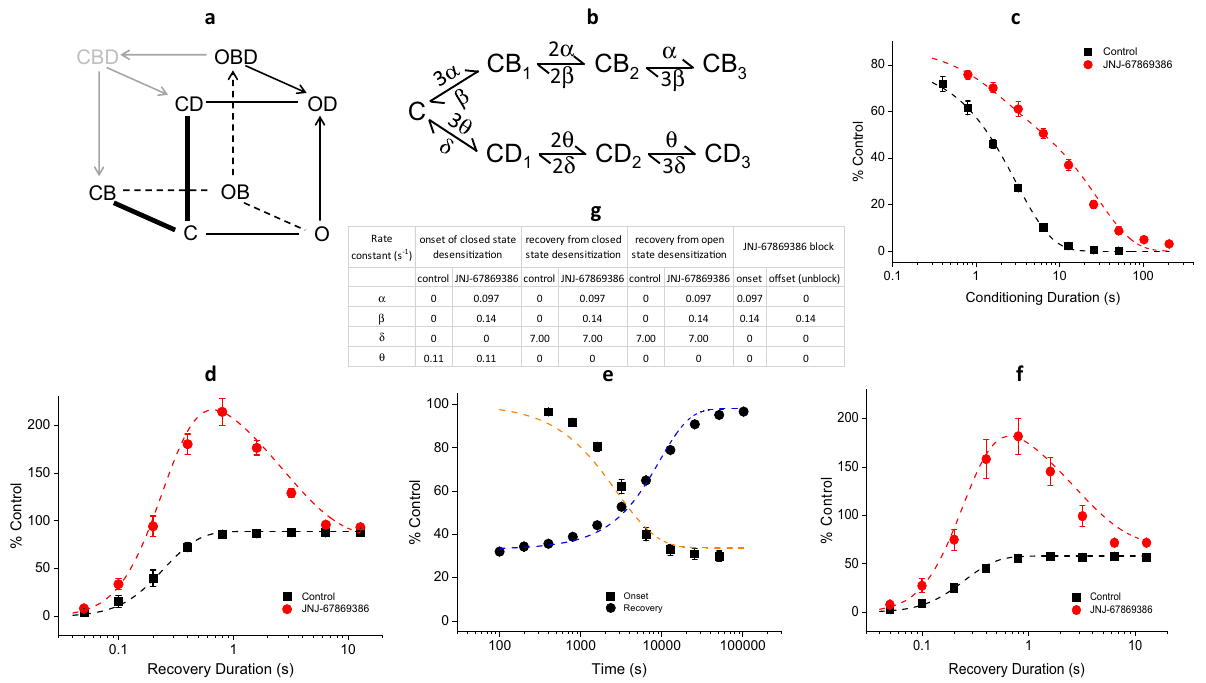
Fig. 6 Kinetic modeling of the effect of JNJ-67869386 on desensitization kinetics. a Qualitative model for channel activation and desensitization in the absence and presence of compound. In the presence of compound, closed-state desensitization and recovery involve only three states, CB, C, and CD (transitions between these states are represented by thick lines). Recovery from (equilibrated) open-state desensitization funnels through the same three states, after an initial rapid transition from OD → CD. Recovery from (unequilibrated) open-state desensitization, i.e., before compound dissociation (OBD → OD) is completed, takes an additional path via CBD (grayed), a pass-through state, as follows: OBD → CBD → CB → C. Arrowed lines indicate irreversible transitions. b Linear kinetic model used for kinetic simulations. Compound-bound desensitized states are excluded from the scheme. c Simulated responses (dashed lines) of the onset of closed-state desensitization overlaid with experimental data from Fig. 3c. d Simulated responses (dashed lines) of recovery from closed-state desensitization overlaid with experimental data from Fig. 3f. e Simulated responses (dashed lines) of onset of and recovery from compound inhibition overlaid with experimental data from Fig. 5a (without steady-state subtraction) and Supplementary Fig. 3. f Simulated responses (dashed lines) of recovery from open-state desensitization overlaid with experimental data from Fig. 4e. g Rate constants used for the simulations. All simulations are performed with the same set of parameter values given in the table (taking into account irreversible transitions as appropriate). For recovery from desensitization, the initial state is set to be CD 3